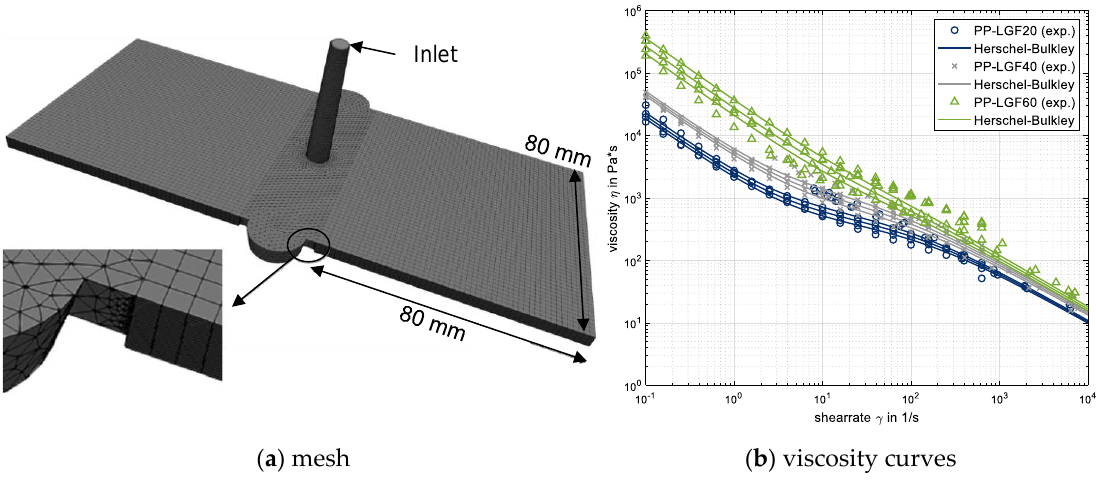
Figure 14. Geometry and material setup of the simulation model.